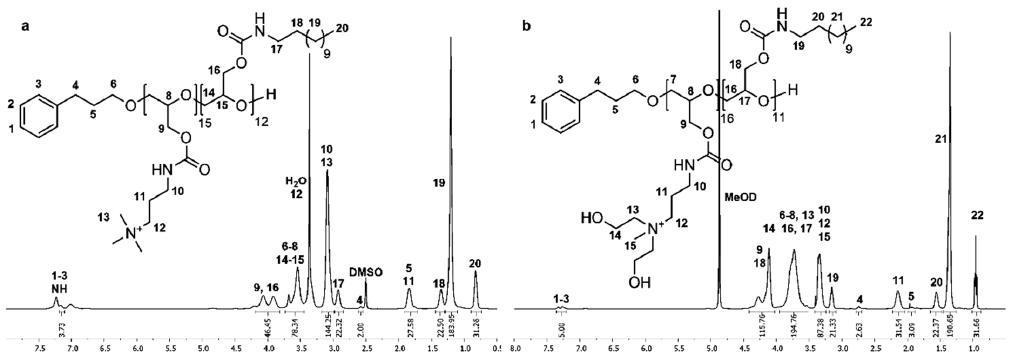
Figure 2. 1 H NMR spectra of P(G TMAPA15 - co -G DDA12 ) ( 5 ) measured in DMSO- d 6 ( a ) and P(G APDEMA16 - co - Figure G DDA11 ) ( 6 ) measured in MeOD ( b ).